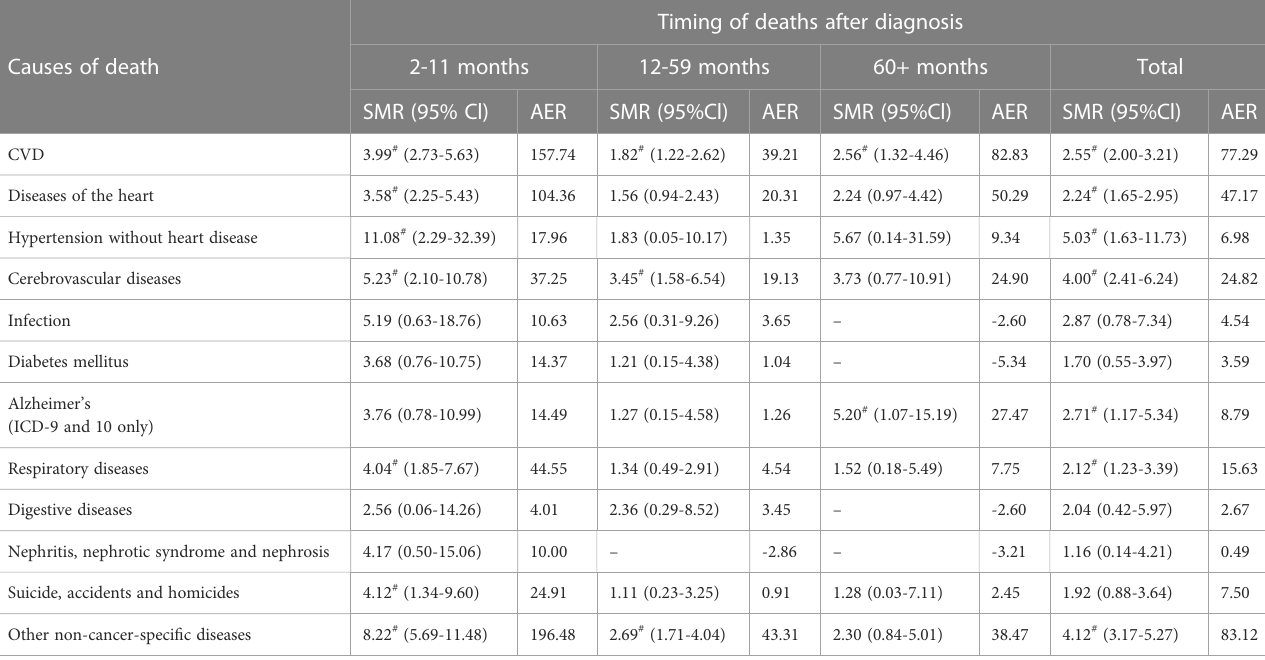
TABLE 2 SMRs and AERs for non-cancer-speci fi c causes of death after PCNSL diagnosis.